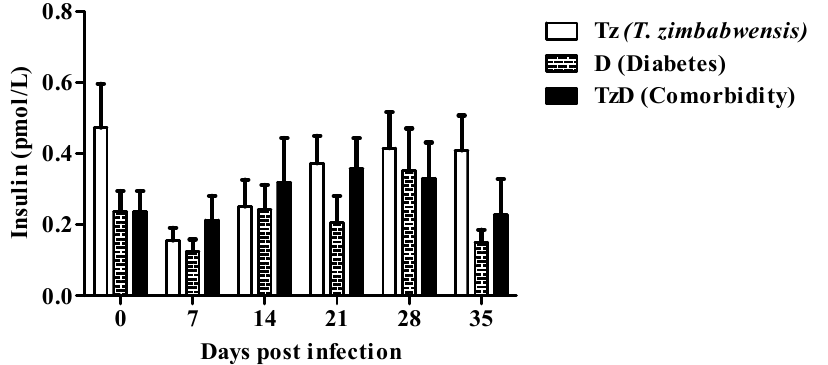
Figure 3. Insulin concentration in groups of male Sprague Dawley rats that were; comorbid with type 2 diabetes mellitus (TzD), diabetic (D) and infected with Trichinella zimbabwensis (Tz). Values are presented as mean ± SEM ( n = 6 for each group).